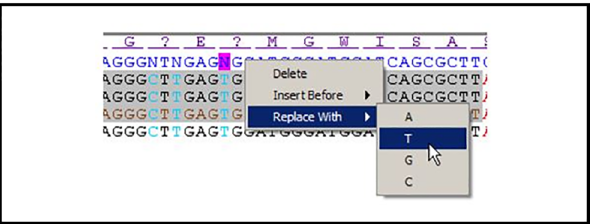
Fig 3. Sequences can be edited. Right clicking on the reference sequence (N) allows the full range of sequence